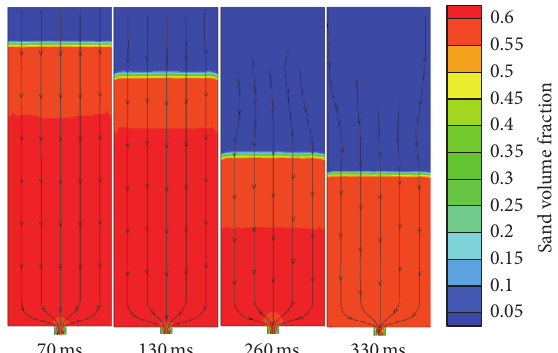
Figure 9: Simulated maps of sand volume fraction and streamlines in the shooting